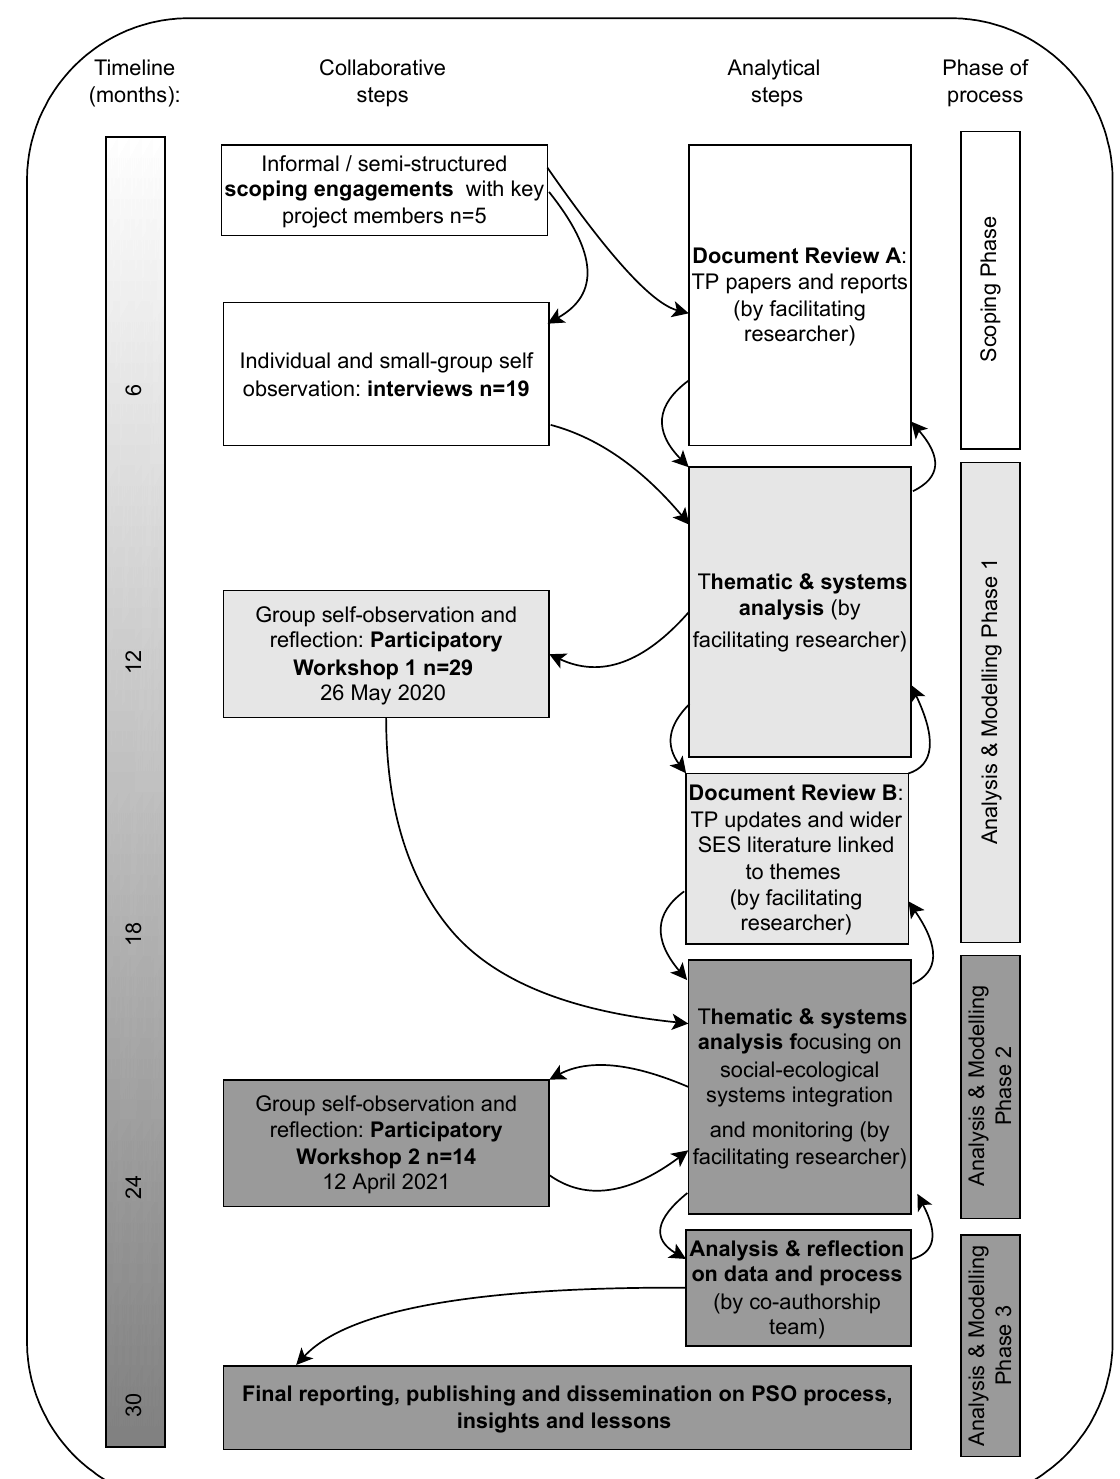
Figure 2. Research process that developed into a ‘participatory self-observation process’ as a social learning process to collaboratively better understand the Tsitsa Project. The process included iterative rounds of collaborative self-observation and reflection by participants. Rounds of analysis and modelling in phases 1 and 2 were done by the facilitating researcher, and analysis and modelling in phase 3 was done by the wider co-authorship team. Insights and lessons learnt were presented in project meetings with the national funder.